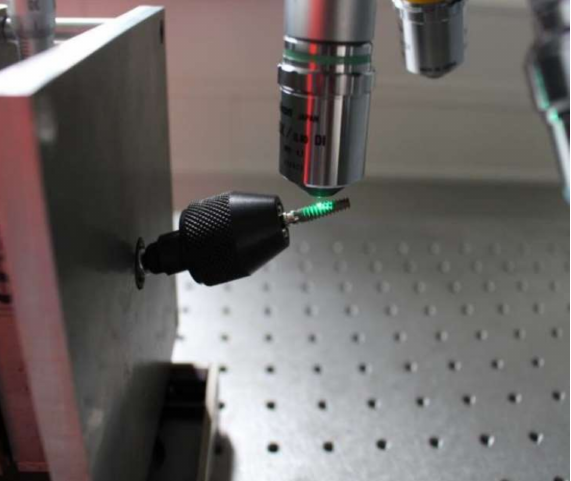
Figure 8. Measurementofimplantroughnessusingwhitelightinterferometerconnectedtothemicroscope.